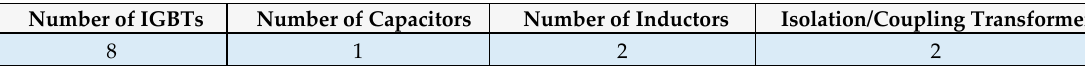
Figure 7. RPC based on a full-bridge back-to-back two-level converter (FB-RPC) with coupling transformers (based on [27]). Table 5. Components quantities of the FB-RPC.